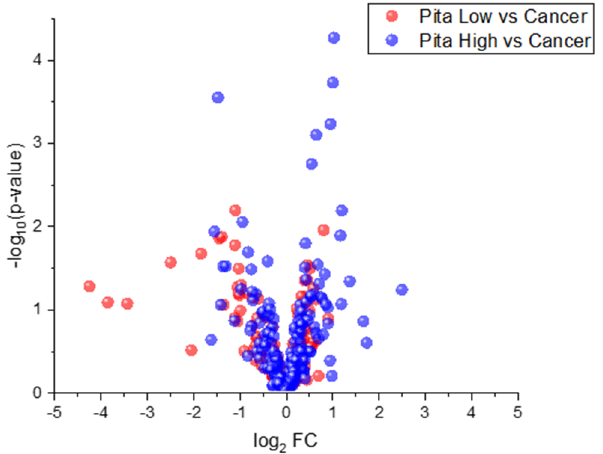
Figure 1. Volcano plot shows more VOCs are differentially expressed between PH (weeks 1–3) and cancer (weeks 1–3) relative to PL (weeks 1–3) and cancer (weeks 1–3).